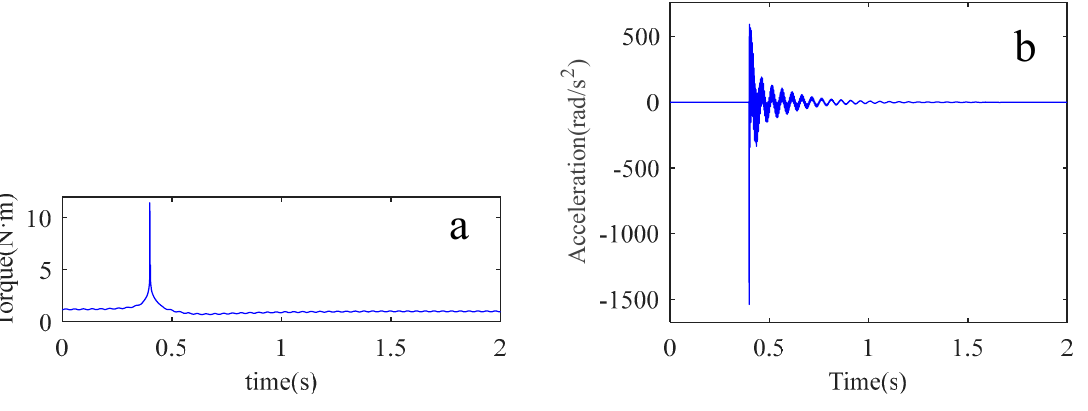
Figure 8. The results of the impact experiment. ( a ) impact torque signal; ( b ) vibration acceleration signal.